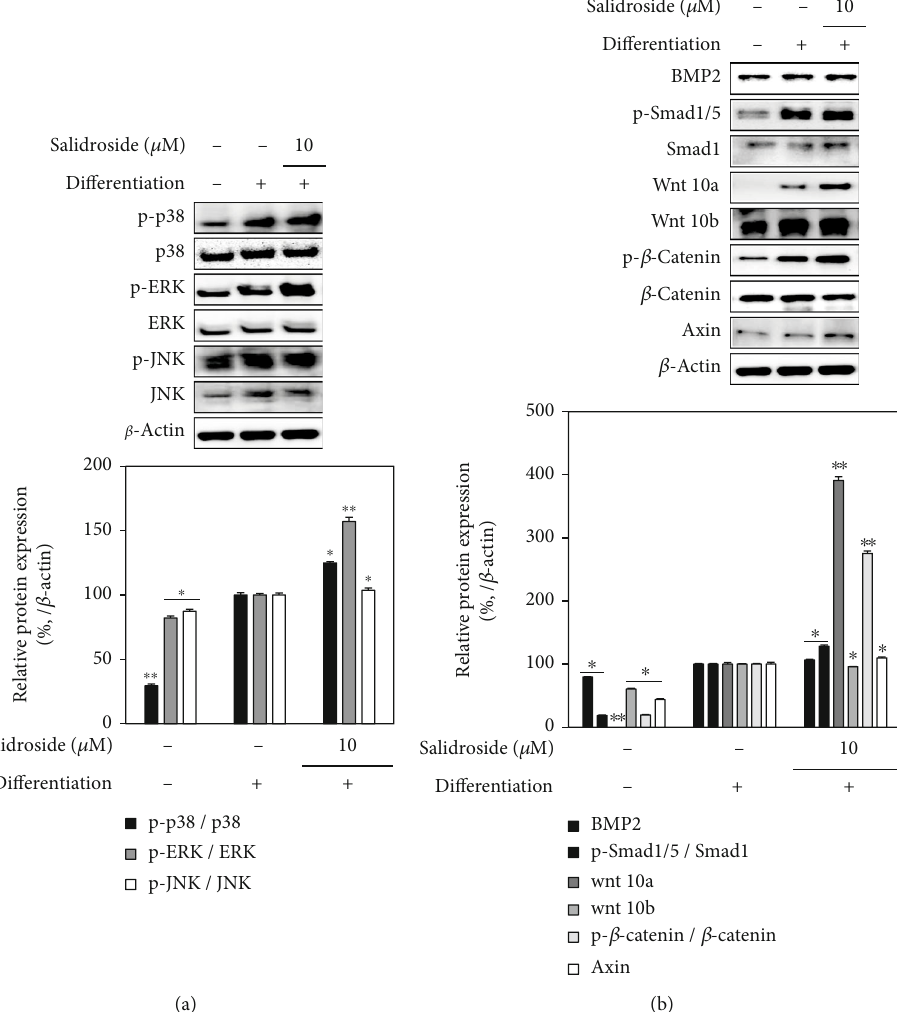
Figure 9: E ff ect of salidroside (10 μ M) on the levels of (a) p38, ERK, and JNK MAPKs and (b) Wnt/BMP signaling pathway. Analysis of protein levels was carried out by Western blotting using the osteo-induced hBM-MSC lysates at day 14 of di ff erentiation with or without salidroside treatment. Western blot bands were densitometrically quanti fi ed and plotted as relative percentage of the untreated di ff erentiated control group. Phosphorylation levels were measured via normalization of the phosphorylated (p-) protein against their total protein levels. β -Actin was used as internal loading control. ∗ p < 0 : 05 and ∗∗ p < 0 : 01 vs. the untreated di ff erentiated control